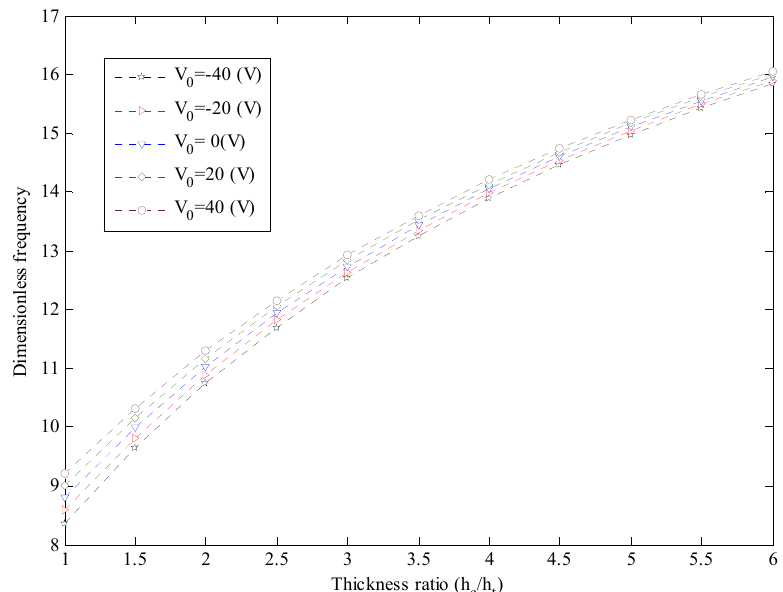
Figure 4. Dimensionless frequency versus thickness ratio for different variations in external electric potential.